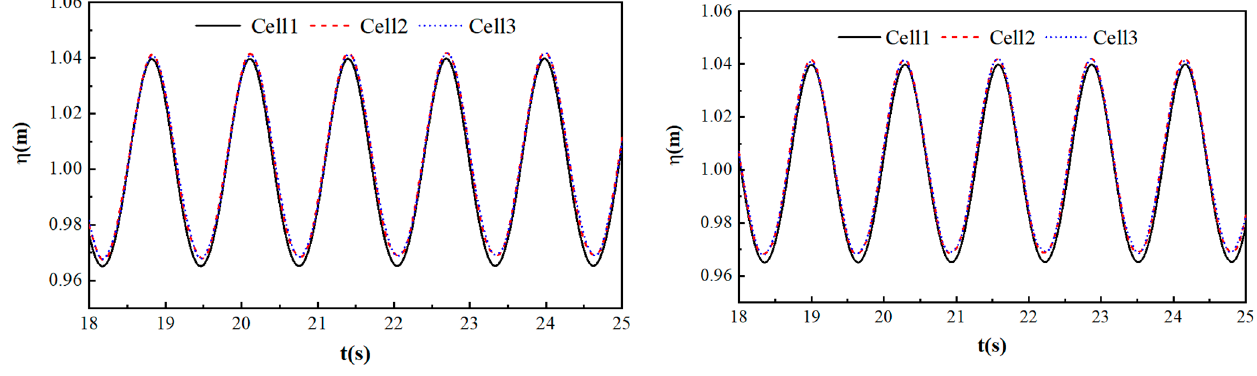
Figure 3. Comparison of the wave elevation of different cells.